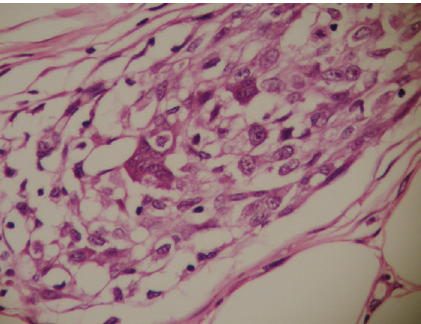
Figure 4: Ki 67 index was 15% ( ×20